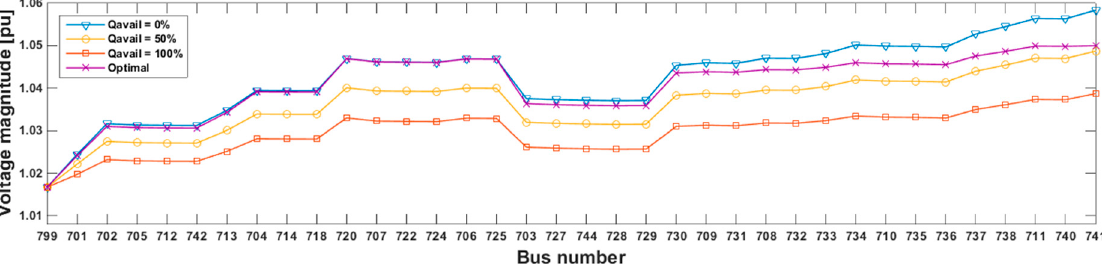
Figure 6. Voltage profiles for light load condition while all DG units output full power.